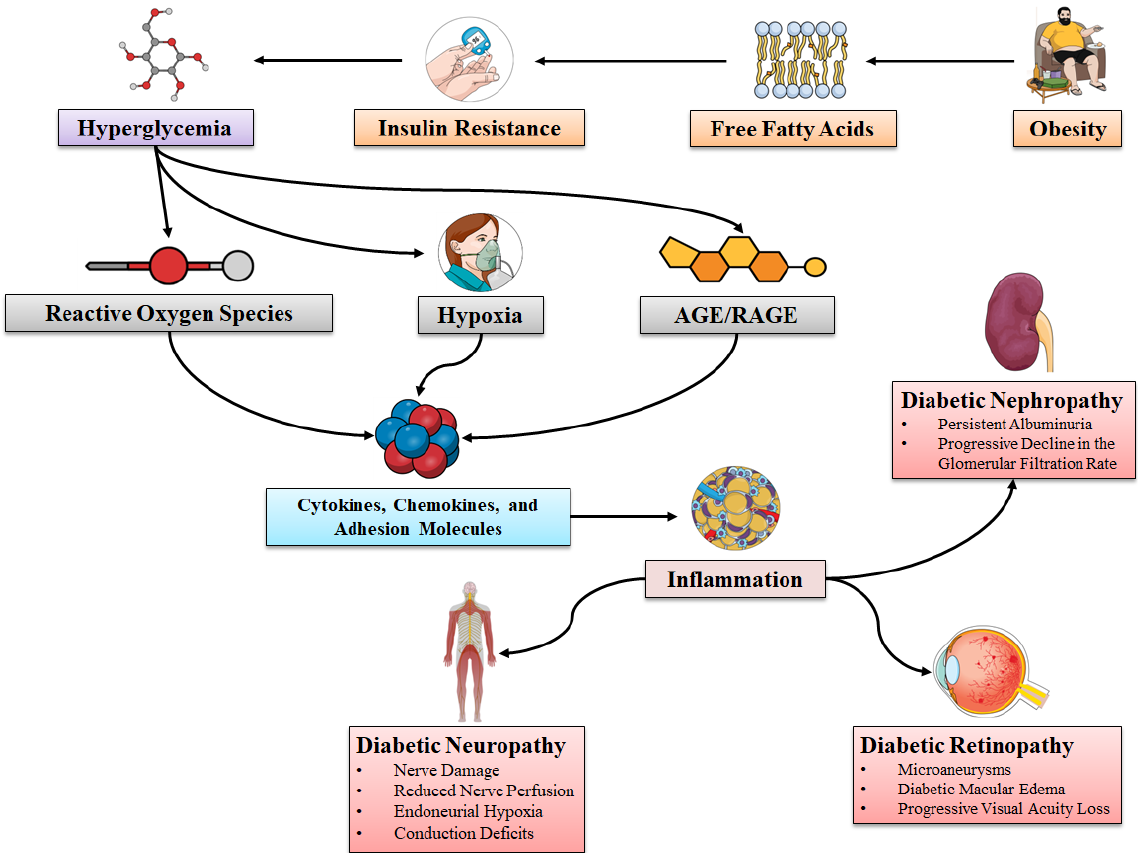
Figure 2. The role of inflammation in diabetic neuropathy, retinopathy, and nephropathy. (Abbre- viations: AGEs, advanced glycation end products; RAGE, receptor for advanced glycation end products).